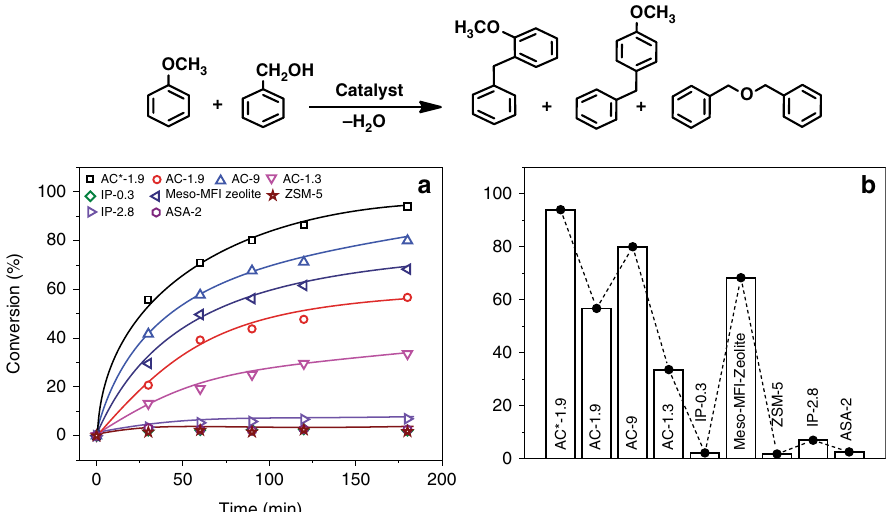
Fig. 3 AAS catalyzed Friedel – Crafts alkylation. Solid acid-catalyzed Friedel – Crafts alkylation of anisole by benzyl alcohol at 120 °C, a reaction kinetics, b total conversion of benzyl alcohol in 3 h reaction time. Error in the conversion is within ±10